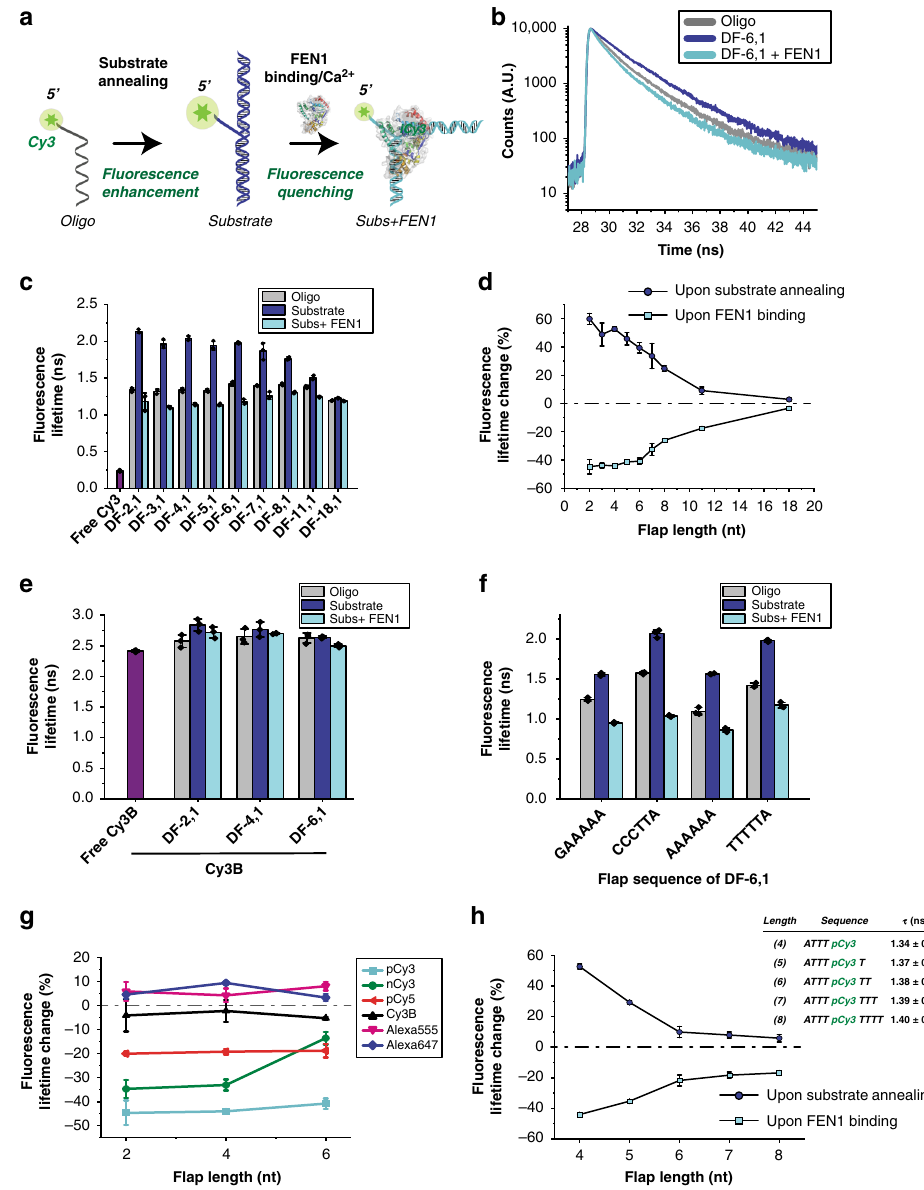
Fig. 2 DNA-mediated bidirectional fl uorescence modulation in the FEN1/DF system. a Schematic showing the oligo bearing pCy3 at its 5 ′ -tip, annealed to two other oligos to form a double fl ap structure (DF) that serves as a substrate for FEN1. The ssDNA fl ap part of the DF is threaded through a narrow pathway in FEN1 for cleavage to happen. b Time-resolved fl uorescence lifetime decays of Cy3 in oligo alone (gray), upon making the DF substrate (blue) and upon addition of FEN1 to the DF substrate (cyan) with a 6 nt-long 5 ′ - fl ap. c Bar chart showing time-resolved fl uorescence lifetime of Cy3 in oligo alone, upon making the DF substrate and upon addition of FEN1 to the DF substrate for fl ap lengths 2 – 18 (color scheme is same as b ). Fluorescence lifetime of free Cy3 dye is included (in purple) for comparison. d Graph showing percentage of change in fl uorescence lifetime, upon annealing of the DF substrate and FEN1 binding to the annealed substrate as a function of fl ap length. e Bar chart graph showing the time-resolved fl uorescence lifetime of Cy3B-labeled oligos alone, upon making the DF substrate and upon addition of FEN1 to the DF substrate for fl ap lengths 2, 4, and 6. Cy3B is linked to the DNA via a 13- carbon linker. f Bar chart showing the time-resolved fl uorescence lifetime of Cy3 in the oligo alone, upon making the DF substrate, and upon addition of FEN1 to the DF substrate for 6 nt-long 5 ′ - fl ap with different fl ap sequences. g Graph showing the percentage of change in fl uorescence, based on lifetime measurements in DF substrates for different fl uorophores and different linkers, with and without FEN1. pCy3 is linked to DNA via 3-carbon linker. Other fl uorophores used are: Cy3B, nCy3, pCy5, Alexa Fluor 555, and Alexa Fluor 647. h Graph showing the percentage of Cy3 fl uorescence change upon annealing of the substrate and addition of FEN1, when pCy3 is incorporated inside the ssDNA fl ap. The inset table lists the fl ap length, sequence, and fl uorescence lifetimes. Error bars and ± represent standard deviation (SD) from three replicates. Oligo sequences are listed in Supplementary Table these interactions, as re fl ected by the local rotational diffusivity of the dye, and the photoisomerization rate from the excited trans state (Supplementary Fig. 2h-inset), suggesting that the dye ’ s freedom and its accessibility to photoisomerization are strongly related.